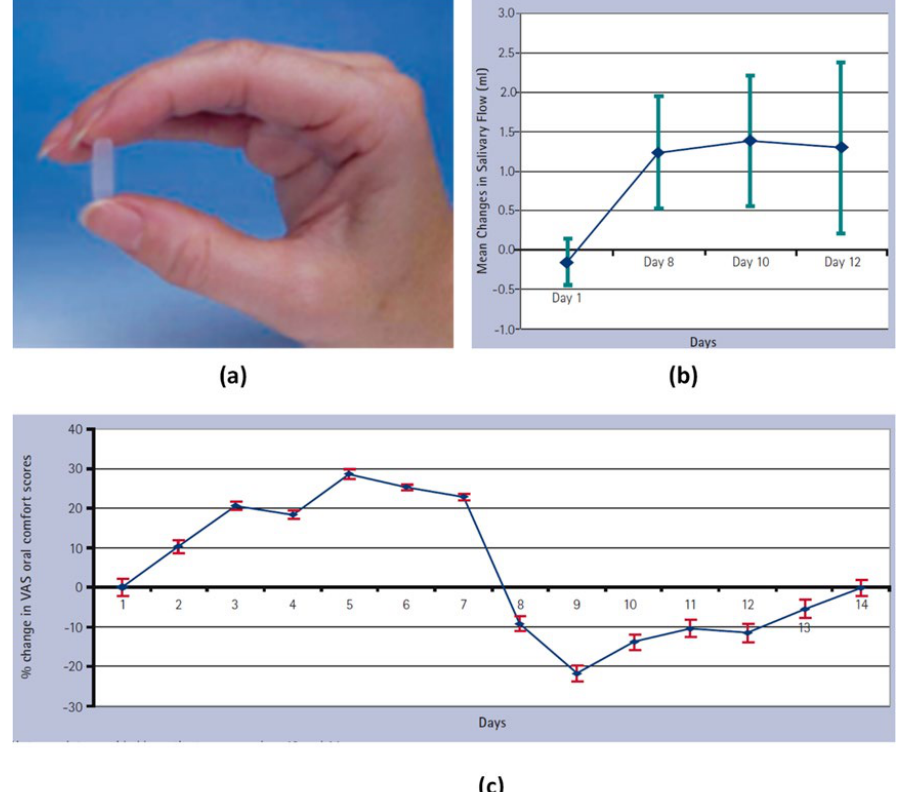
Figure 5. The hydrogel polymeric buccal formulation inserts ( a ), mean change in the salivary flow rates ( b ) and percentage change in visual analogue scale regarding oral comfort scores in patients ( c ). Adopted from [91] .